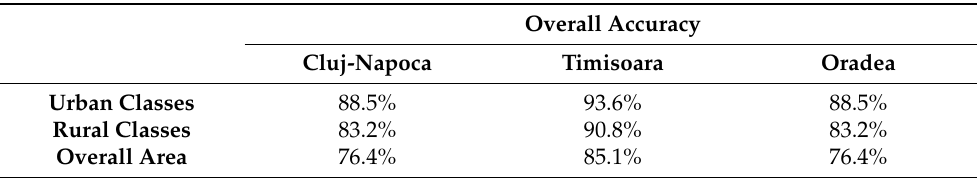
Table 6. Thematic accuracy assessment for 2006 UA data (Source: UA 2006 LU/LC product delivery report).